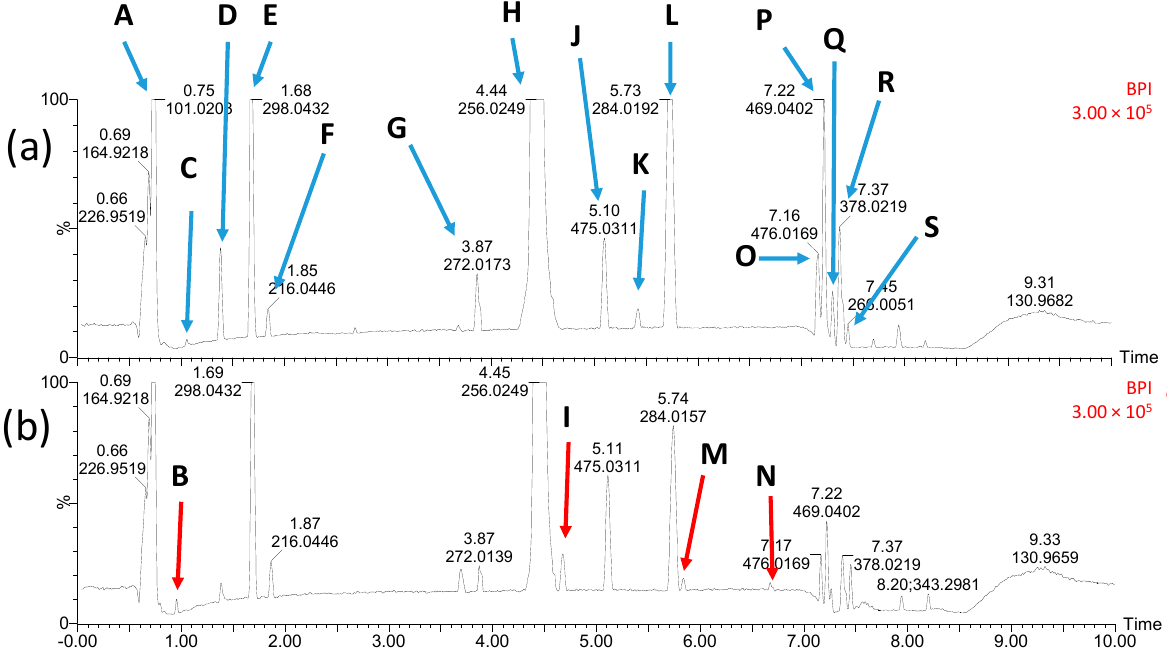
Figure 6. Chromatograms of solutions after STZ degradation with FeSO 4 and: ( a ) 10 mmol/L H 2 O 2 , ( b ) 50 mmol/L H 2 O 2 . The chromatographic peaks of STZ and DPs are labelled with letters from A to S. Chromatograms shown in Figure 6a,b correspond to a solution with lower and